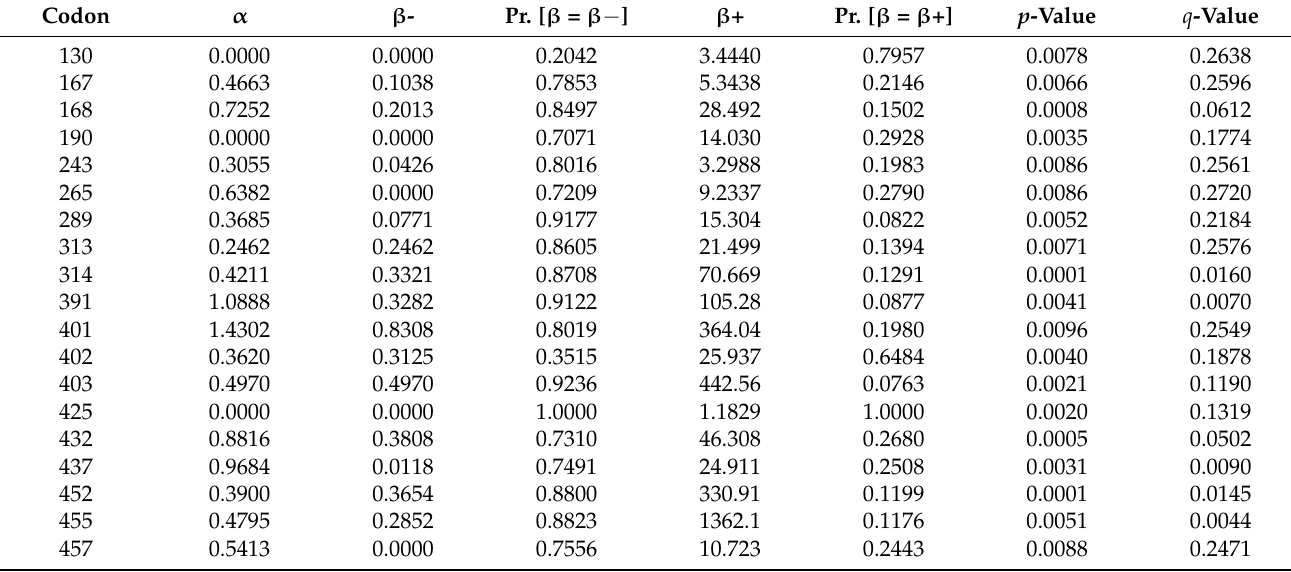
Table 3. Sites under episodic diversifying selection inferred by